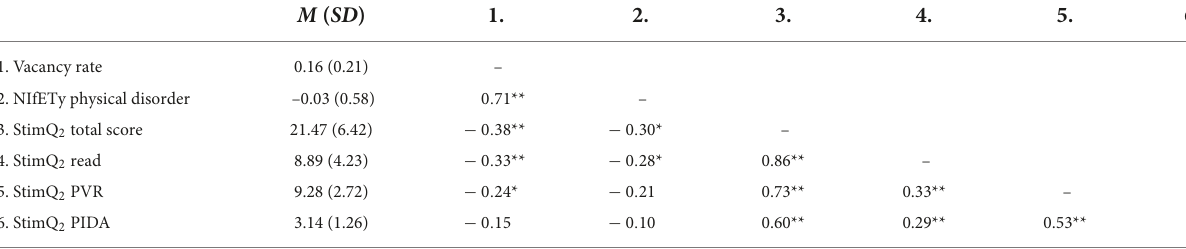
TABLE 2 Descriptive statistics and correlations between primary study variables. M ( SD ) 1.